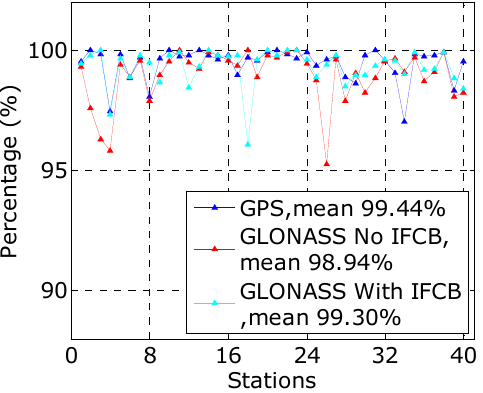
Figure 6. Fixing percentage of daily static precise point positioning (PPP) with different strategies for each rover station. Receivers with homogeneous type are used as rover sites.